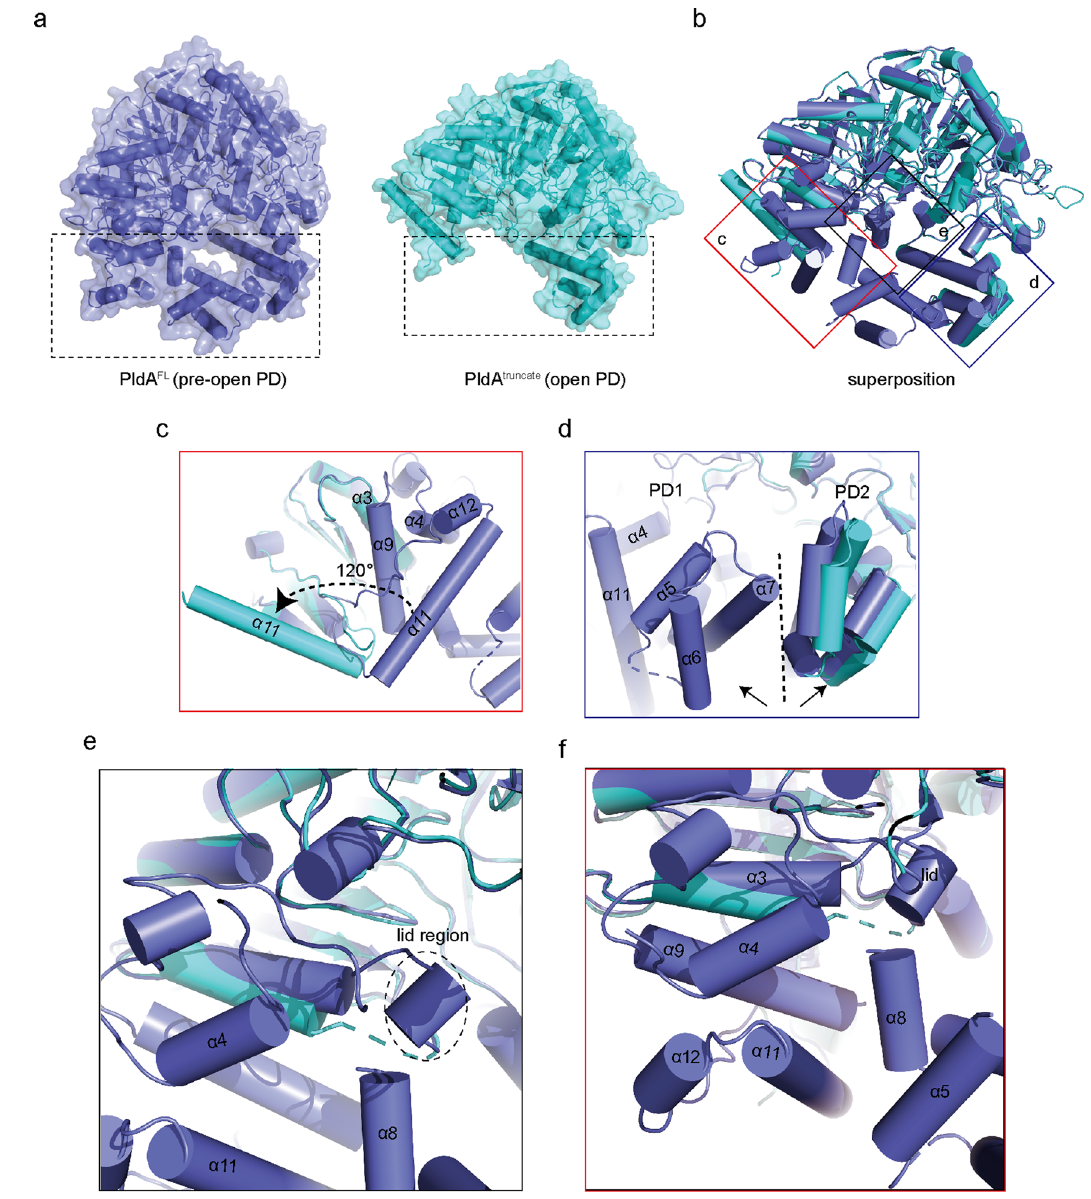
Fig. 3 | Structural comparison of PldA FL and PldA truncate . a Structural comparison of PldA FL (left panel) and PldA truncate (right panel) shown with a transparent surface. b – f Superposition of PldA FL (slate) and PldA truncate (cyan) ( b ) indicates the